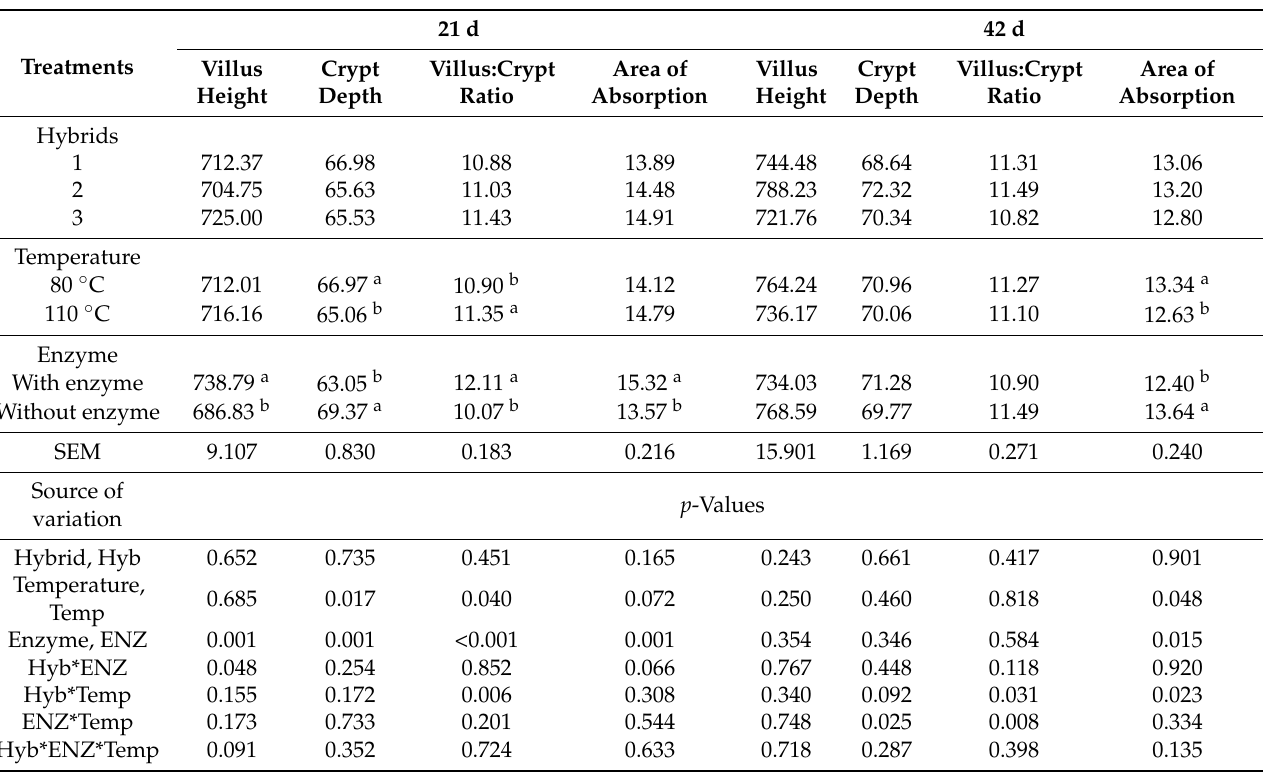
Table 3. Villus height ( µ m), crypt depth ( µ m), villus:crypt ratio, and area of absorption ( µ m 2 ) of the jejunum of broilers fed diets containing different corn hybrids, dried at two temperatures, and with or without the inclusion of an enzymatic